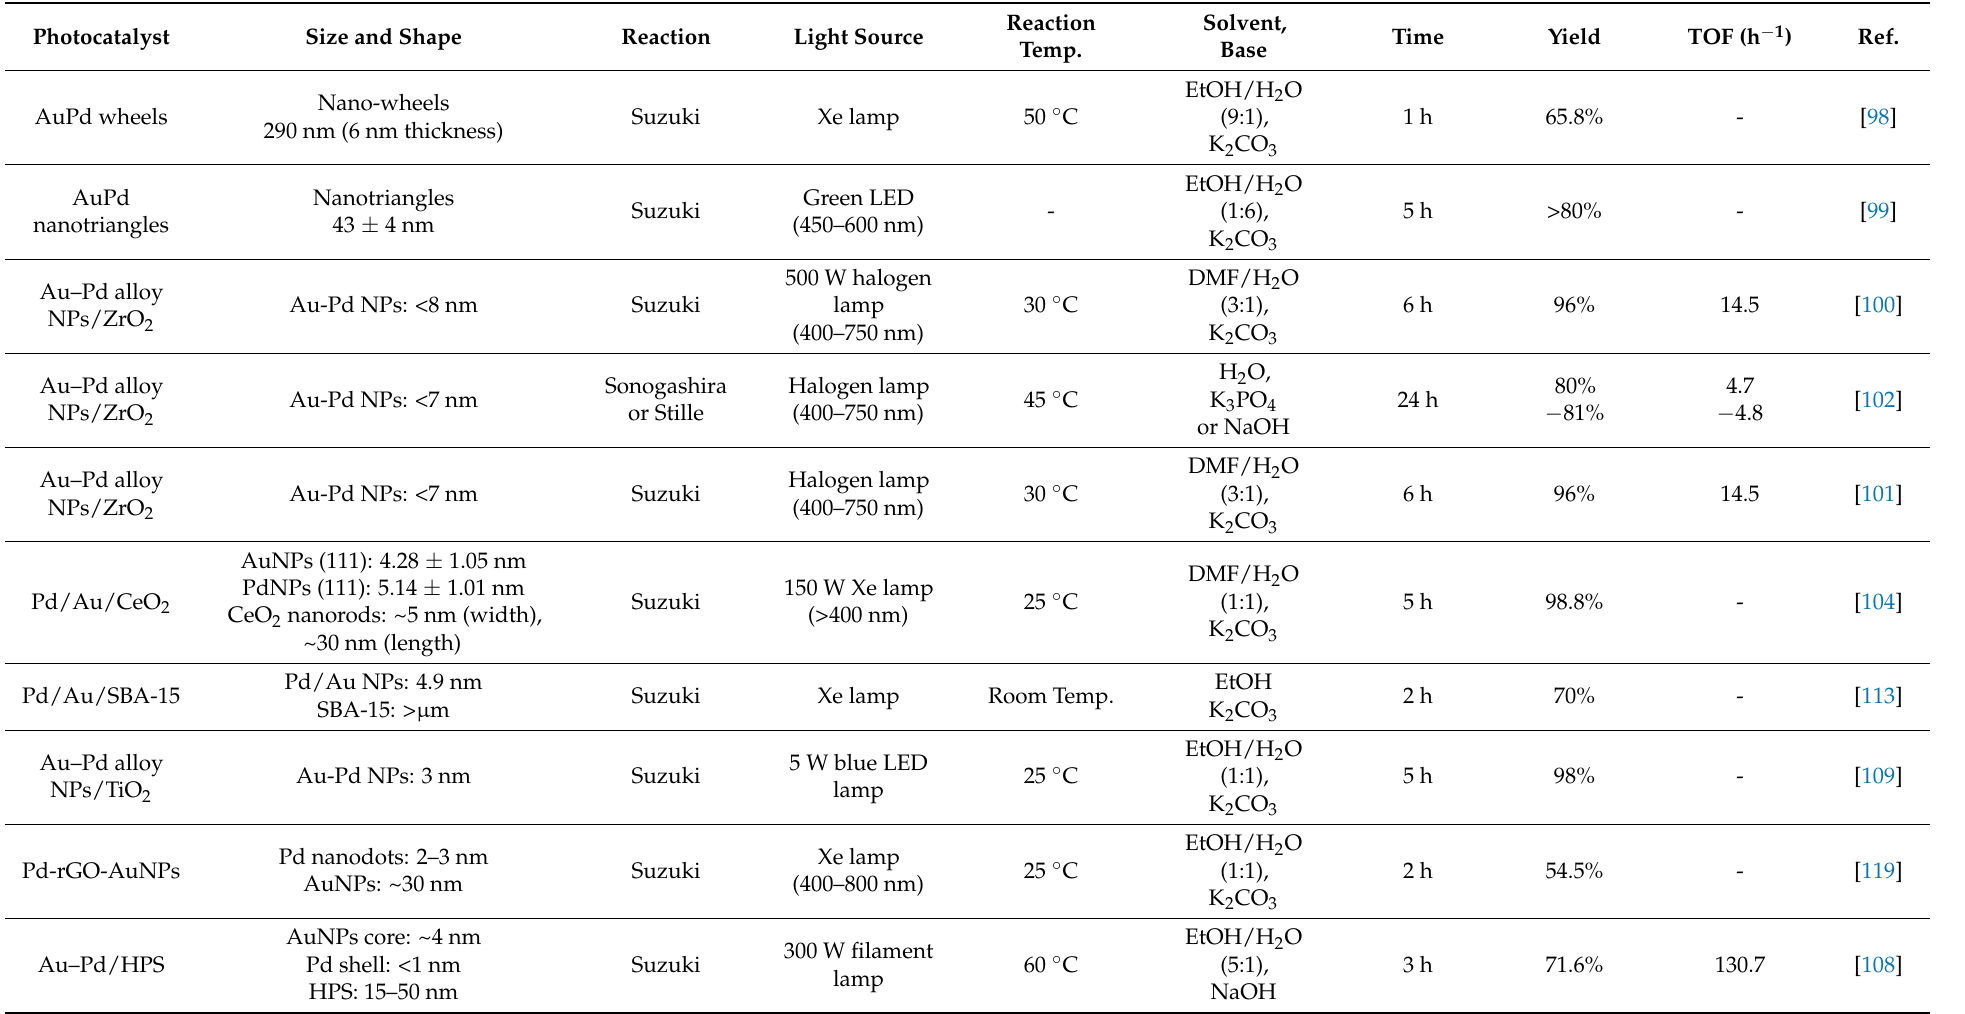
Table 2. Plasmonic hybrid nano-catalysts for various photocatalytic C–C cross-coupling. AuNP-, AgNP-, CuNP-assisted photocatalysts under visible and NIR light. Photocatalyst Size and Shape Reaction Light Source